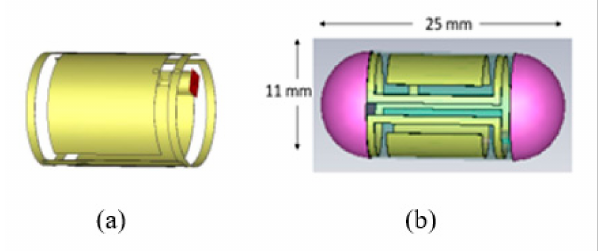
Figure 13. ( a ) UWB capsule antenna, ( b ) UWB capsule endoscope model.